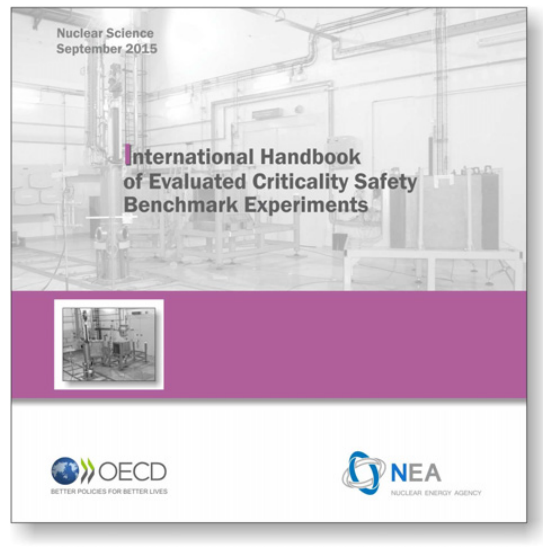
Figure 1. September 2015 cover of the ICSBEP Handbook. Figure 2. March 2015 cover of the IRPhEP